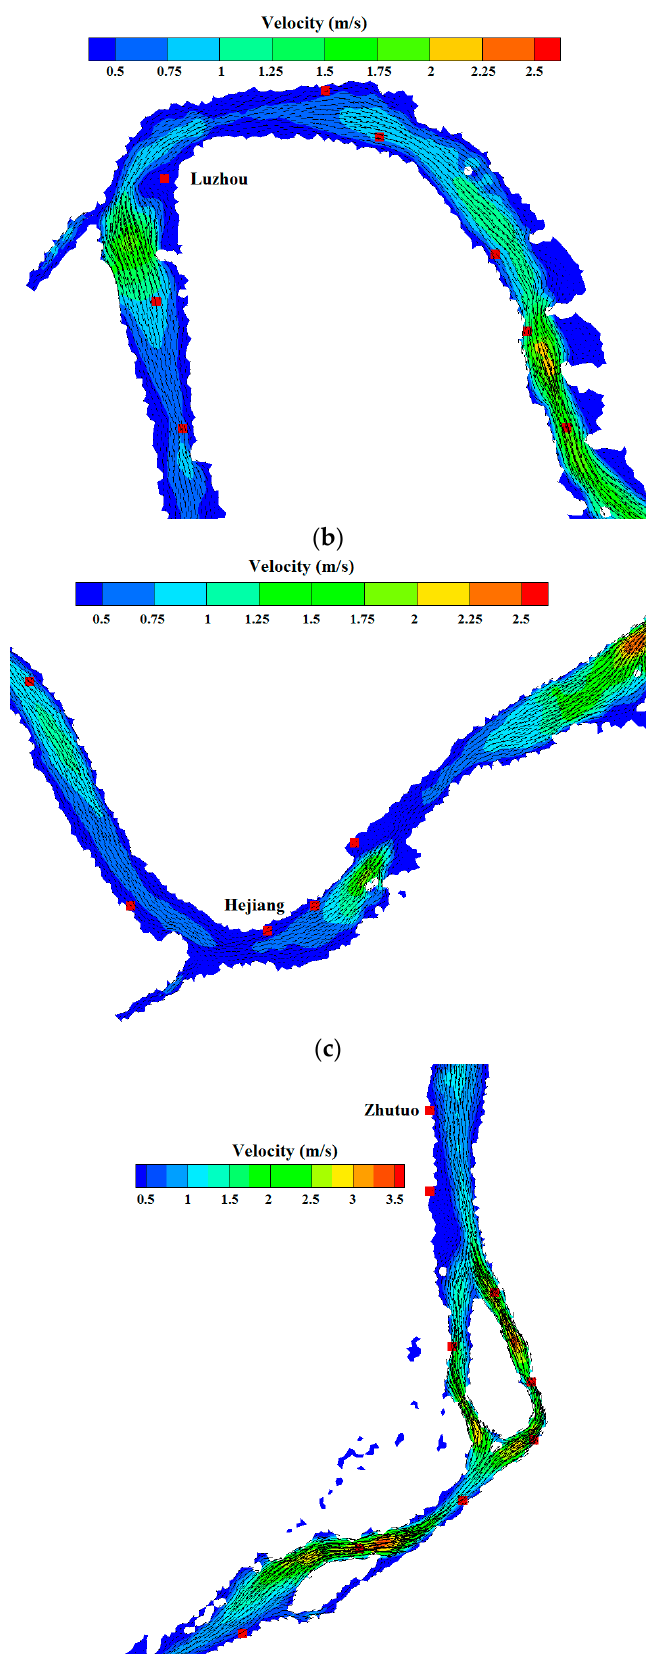
Figure 5. Computed flow velocity field on key site along the studied river reach, with red squares indicating the nearby gauging stations: ( a ) Yibin; ( b ) Luzhou; ( c ) Hejiang; and ( d ) Zhutuo.